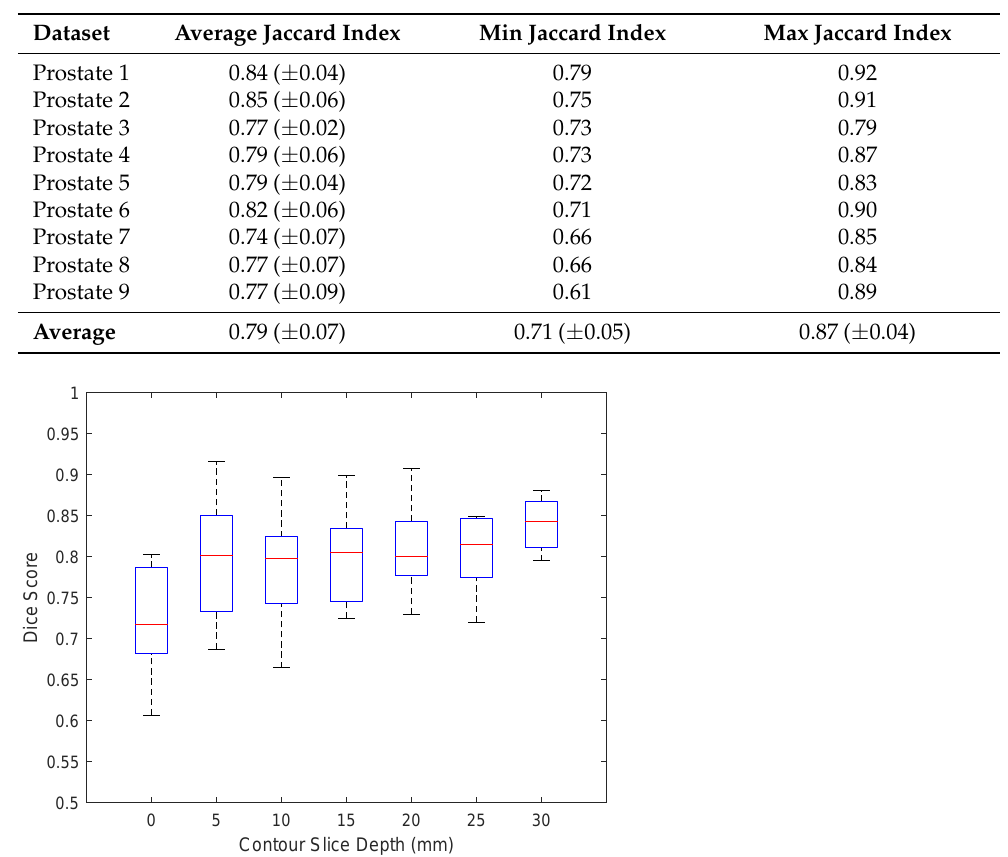
Table 3. Prostate segmentation Jaccard index results.